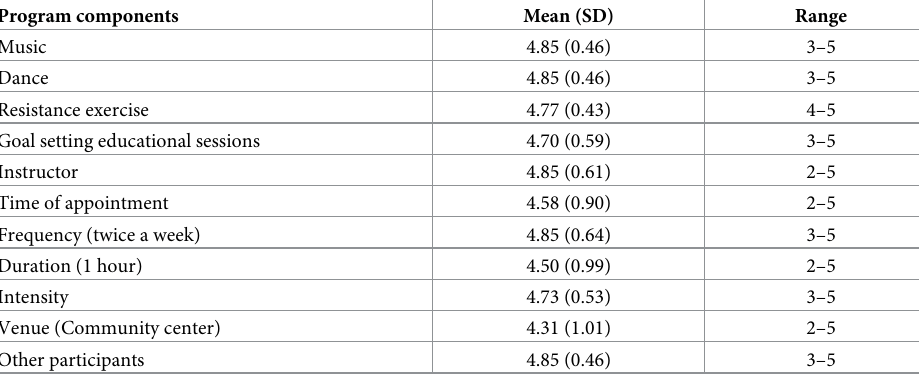
Table 3. Satisfaction score 1 for Bollywood Dance Fitness